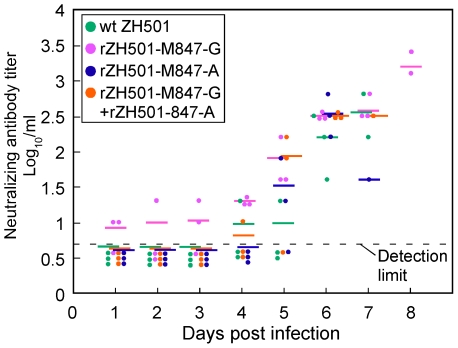
Neutralizing antibody titers in the infected mice.Serum neutralizing antibody titers of five-week-old female CD-1 mice inoculated i.p. with 105 PFU of ZH501, rZH501-M847-A, rZH501-M847-G or a mixture of rZH501-M847-A and rZH501-M847-G. Dashed line denotes the minimum neutralizing antibody detection level.